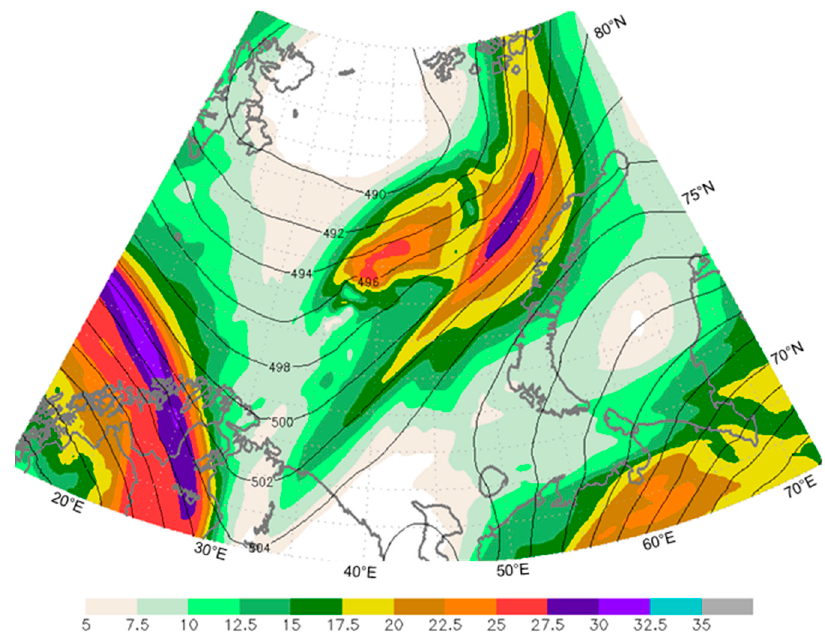
Figure A4. ICON-A6.5: wind speed at H500. Valid time 04:00 UTC 26 February